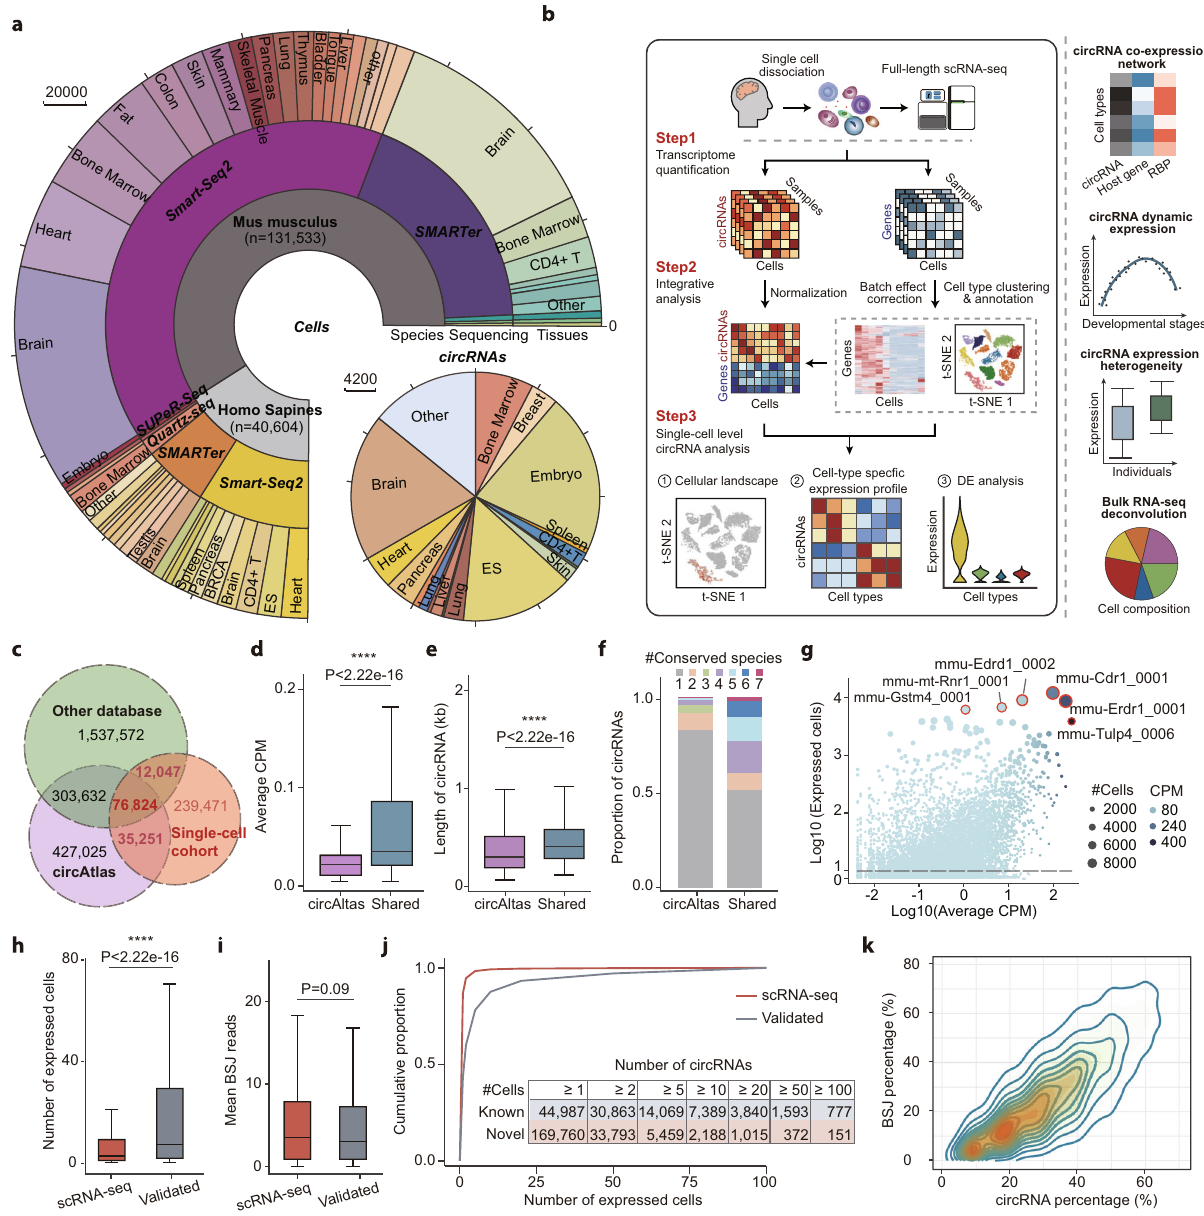
Fig. 1 Discovering circRNAs from large-scale full-length single-cell RNA-seq datasets. a The total number of cells and circRNAs detected in the collected scRNA-seq datasets. b Work fl ow of scRNA-seq data integration and circRNA detection (see Methods). c Overlap of circRNAs detected in the scRNA-seq datasets, circAtlas database, and the integration of other 10 bulk RNA-seq based databases. d The average expression levels (counts per million, CPM) of circRNAs in the circAtlas database. Colors represent circRNAs that were uniquely detected in circAtlas (purple, n = 730,657) or simultaneously detected in circAtlas and the scRNA-seq cohort (blue, n = 112,075). e The length of fully assembled sequence of 619,060 circAtlas-speci fi c and 103,758 circRNAs shared between circAtlas and the scRNA-seq cohort. f The number of species that circRNAs were conservatively expressed in. g Log-scaled mean expression level and the number of expressing cells for mouse circRNAs. Sizes of points indicate the number of expressing cells. Filled colors represent the mean CPM of circRNAs. h , i The number of circRNA host cells ( h ) and mean BSJ reads ( i ) of circRNAs ( n = 239,471) that were uniquely detected in the scRNA-seq data or validated circRNAs ( n = 114,919) which were also observed in bulk RNA-seq circRNA databases. j Cumulative distribution of mouse circRNAs ordered by the number of expressing cells. The scRNA-seq speci fi c and validated circRNAs are colored in red and grey, respectively. k Expression of scRNA-seq speci fi c circRNAs in cells that have more than 10 BSJ reads in total. The x- and y -axis represent the proportion of scRNA-seq speci fi ccircRNA number and BSJ reads in these cells, respectively. Colors indicate the density of circRNAs at each point. All center lines in the box plots indicate the median values, and box limits indicate the upper and lower quartiles of plotted values. The upper and lower whiskers indicate the largest and smallest values within the range of 1.5x interquantile range (IQR) distance from the box limits. **** P < 0.0001, Wilcoxon rank-sum test (two-sided). Source data are provided as a Source Data fi le.